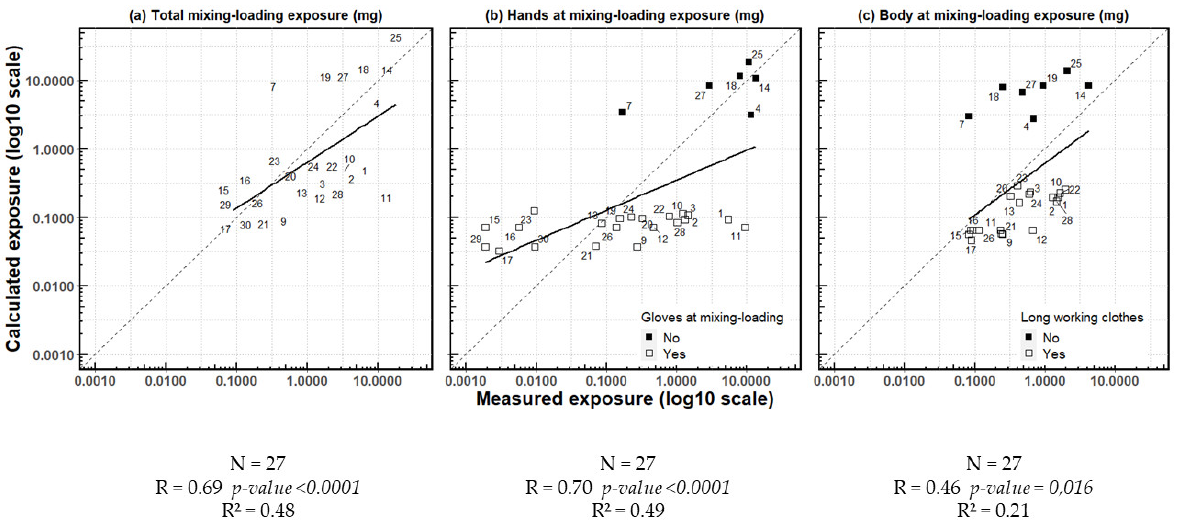
Figure 5. Linear regression of exposure calculated using the AOEM and exposure measured in the CANEPA study during application and according to body parts.